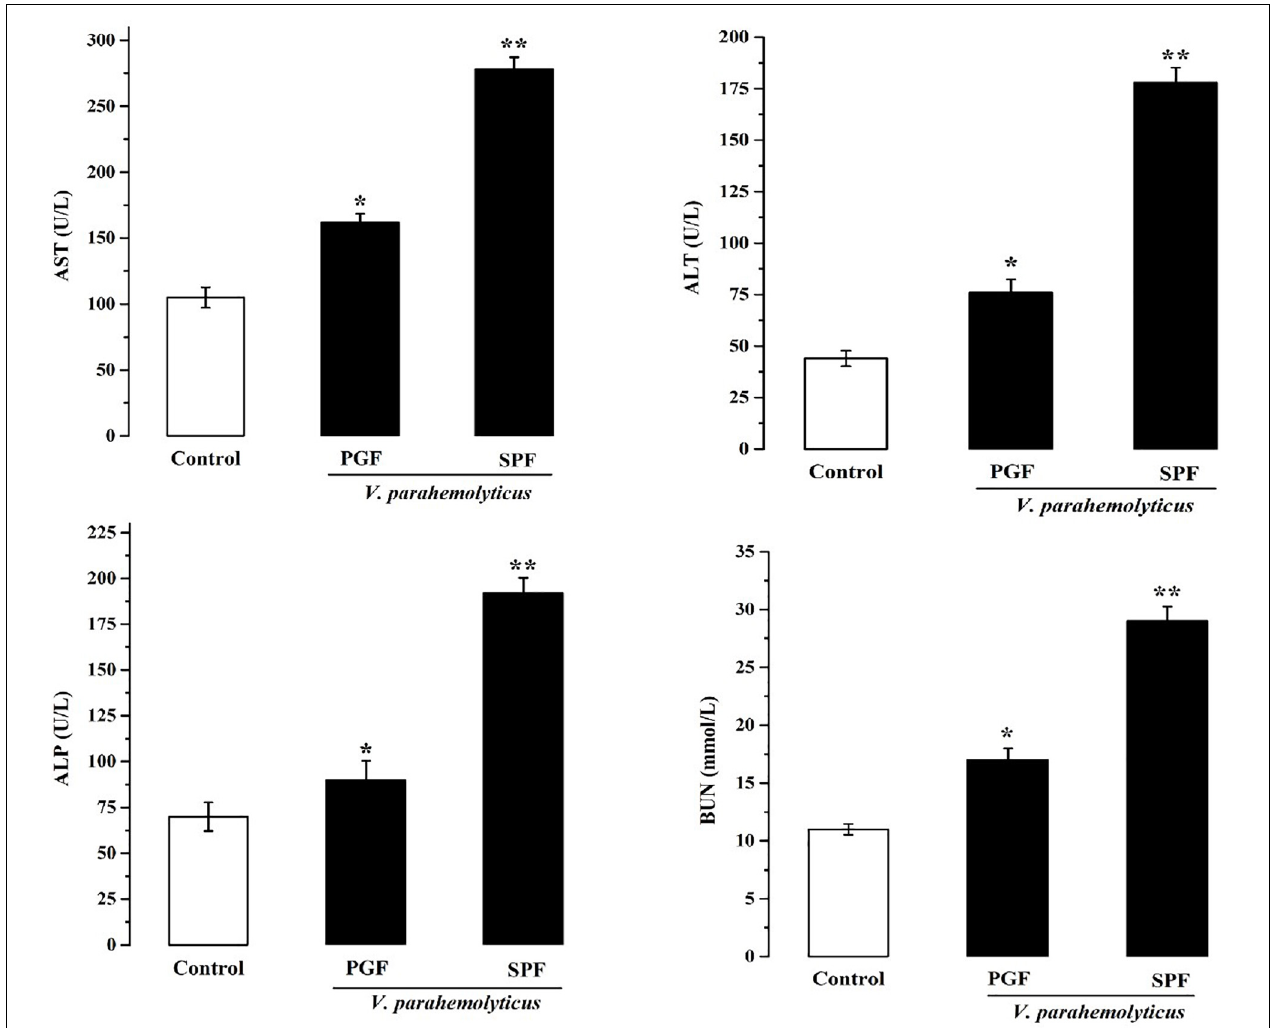
FIGURE 2 | Effects of Vibrio parahaemolyticus on serum AST, ALT, ALP, and BUN indices of pseudo germ-free (PGF) and normal (SPF) mice. Data are expressed as the mean ± SEM ( n = 5) compared with the control group gavaged with fresh sterilized LB medium. * p < 0.05; ** p <